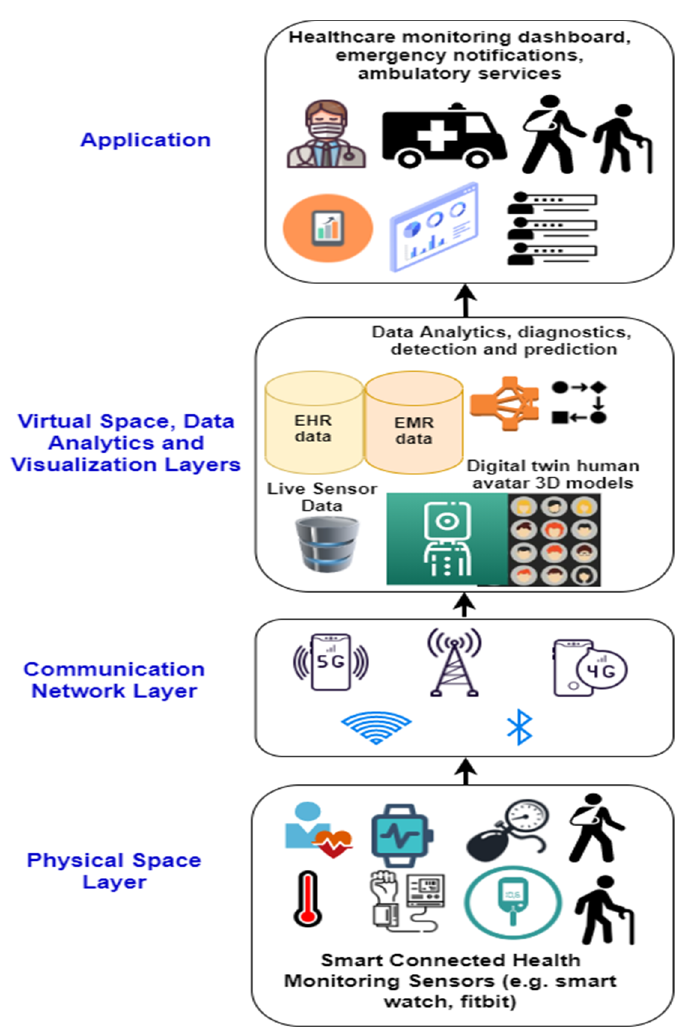
Figure 5. Use-case analytics’ paradigm for a smart healthcare patient monitoring digital twin in DAVL.